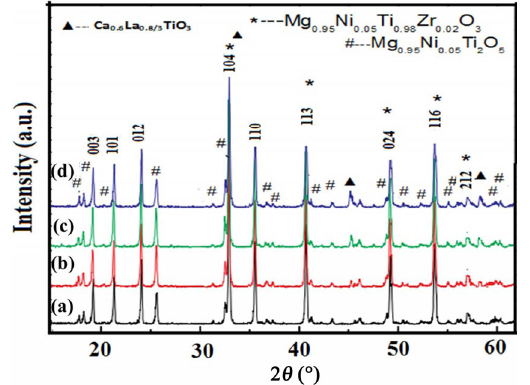
Fig. 3 Backscattered electron images of (1 − x )Mg 0.95 Ni 0.05 - Ti 0.98 Zr 0.02 O 3 – x Ca 0.6 La 0.8/3 TiO 3 ceramics: (a) x = 0, (b) x = 0.05, (c) x = 0.1, (d) x =